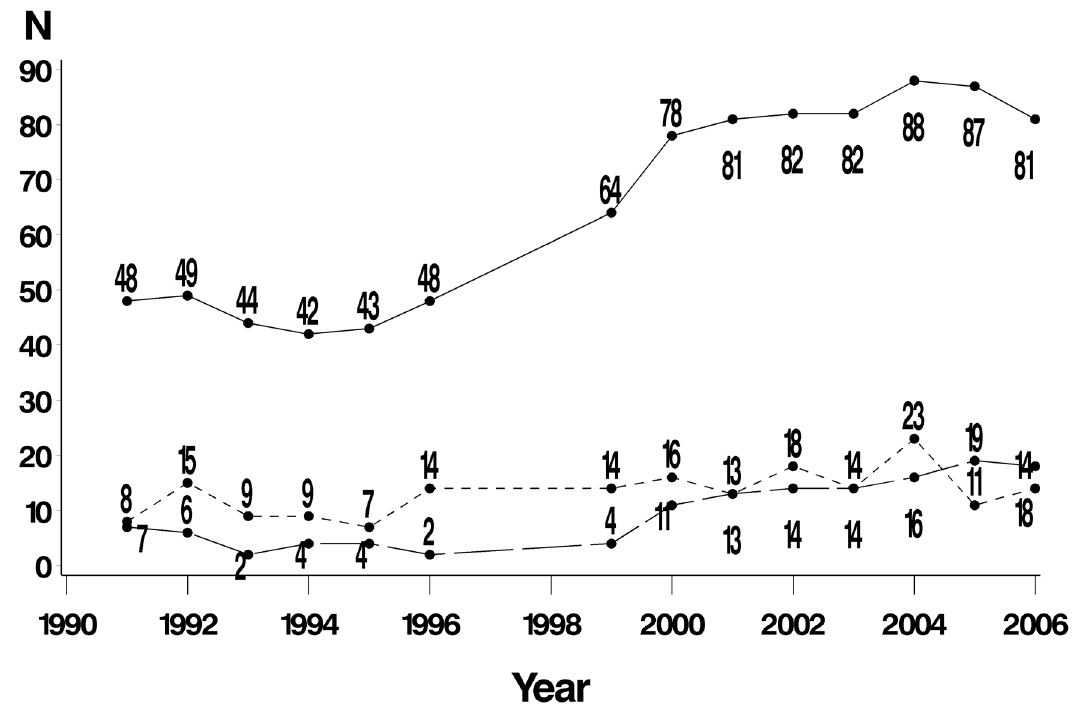
Figure 2. Inferred total number of otters (solid line), cubs (dotted line) and transients (dashed).